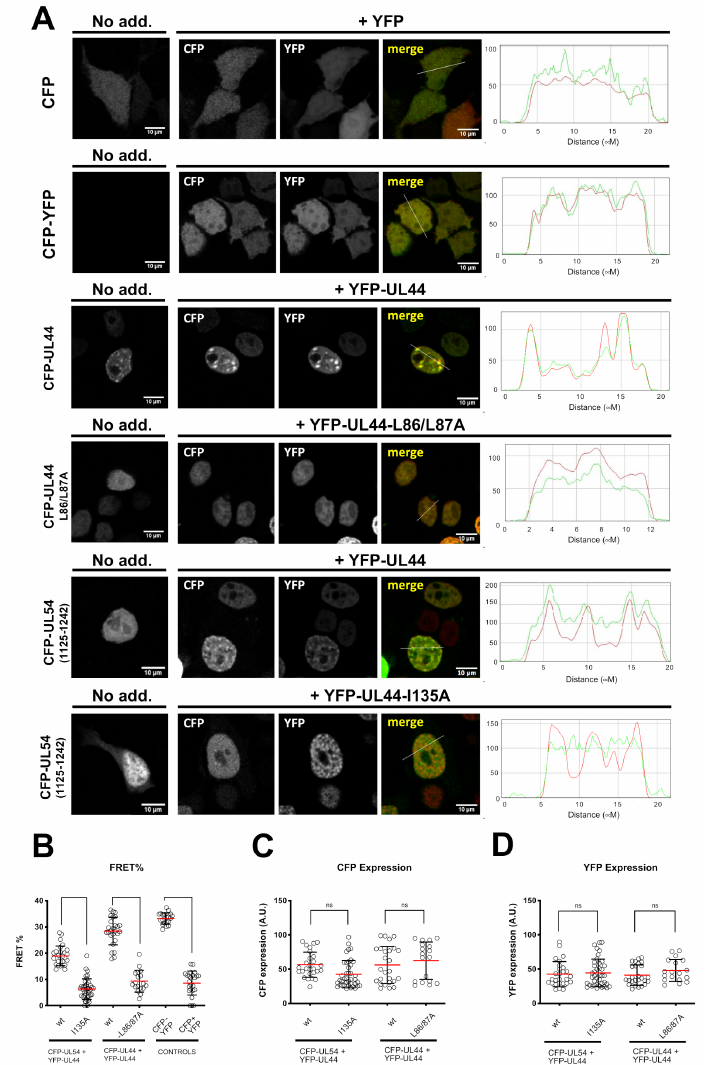
Figure 2. Specific residues are involved in ppUL44 dimerization in cells. HEK293T cells were seeded on glass coverslips and transfected with the indicated expression plasmids; 48 h p.t., cells were fixed and processed for IF, before being analyzed by confocal laser scanning microscopy (CLSM) to investigate the subcellular localization of the indicated fusion proteins. ( A ) The subcellular localization of CFP fusions as expressed alone (left panels) or in the presence of YFP fusions (middle panels) is shown, together with the correspondent RGB profiles (right panels). Cell micrographs such as those shown in ( A ), were subjected to FRET acceptor photobleaching to calculate fluorescence resonant energy transfer (FRET) efficiency ( B ), as well as the CFP ( C ), and YFP ( D ) expression level of individual cells relative to each indicated FRET pair, as described in the Materials and Methods section. Data shown are the mean + standard deviation of the mean relative to at least 20 cells from two independent experiments, along with the p -value relative to the indicated groups of FRET pairs, calculated using the ordinary one-way ANOVA with Tukey correction: **** = p ≤